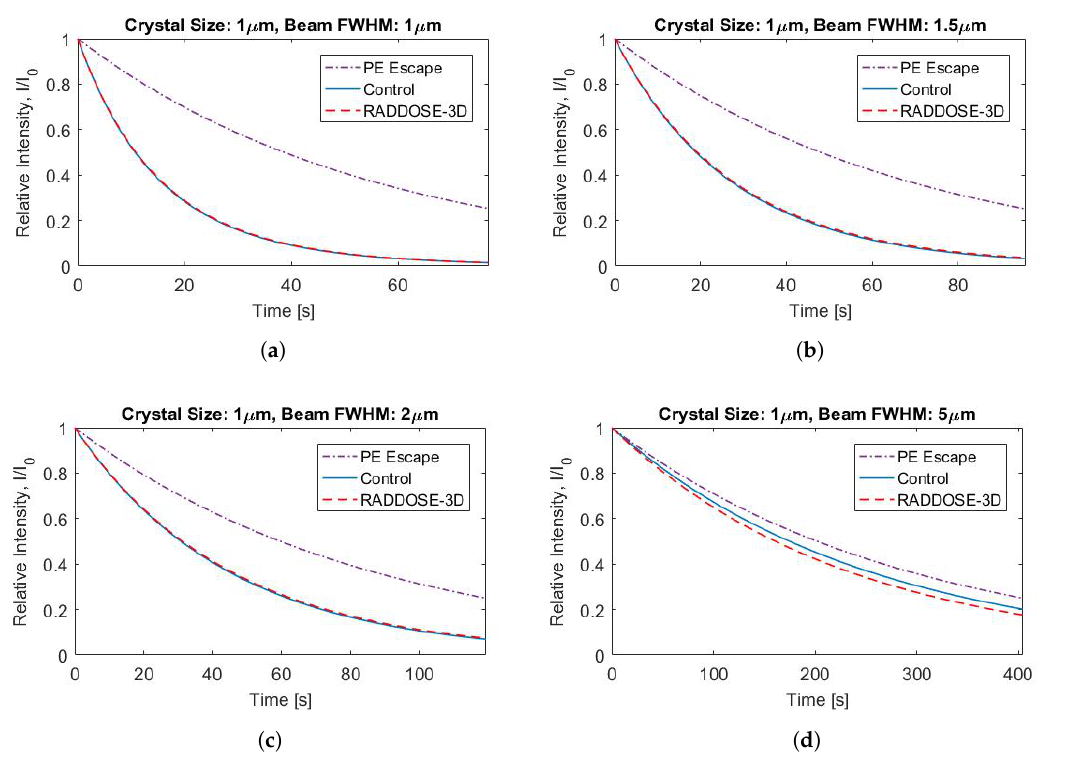
Figure 2. Relative intensity, I / I 0 , as a function of time, for a 3Å Bragg spot generated by a 1µm crystal centred in X-ray beams of varying width. All beams had energy of 12keV and incident flux of 1 × 10 10 photonss −1 . The beam FWHM was: ( a ) 1µm; ( b ) 1.5µm; ( c ) 2µm; and ( d ) 5µm. Three sets of dose maps were used in the simulations: Purple dot-dash lines and solid blue lines show results based on our simulated dose maps (see Section 4.5). The former accounted for PE escape, the latter (control) did not; both accounted for Compton scattering. Dashed red lines show results based on RADDOSE-3D [9] dose maps; the version used did not account for either PE escape or Compton scattering. The discrepancy between the simulation that accounts for PE escape and those that do not becomes more significant as the beam size decreases from 5µm to 1µm. No significant variation is observed between the two simulations that did not account of PE